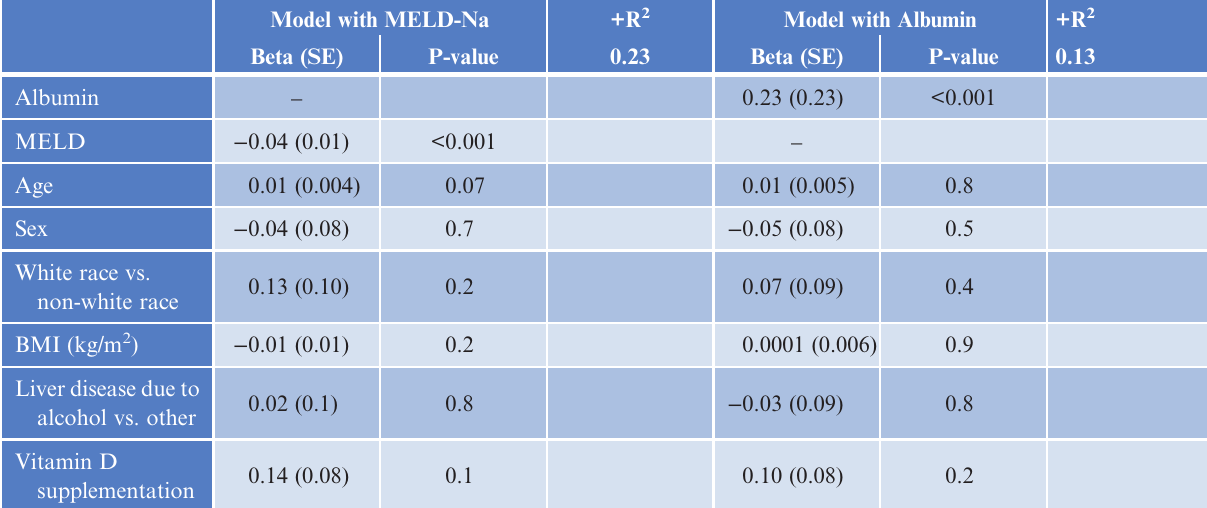
Table 3. Results of linear regression models with log transformed 25(OH)D levels as dependent variable Model with